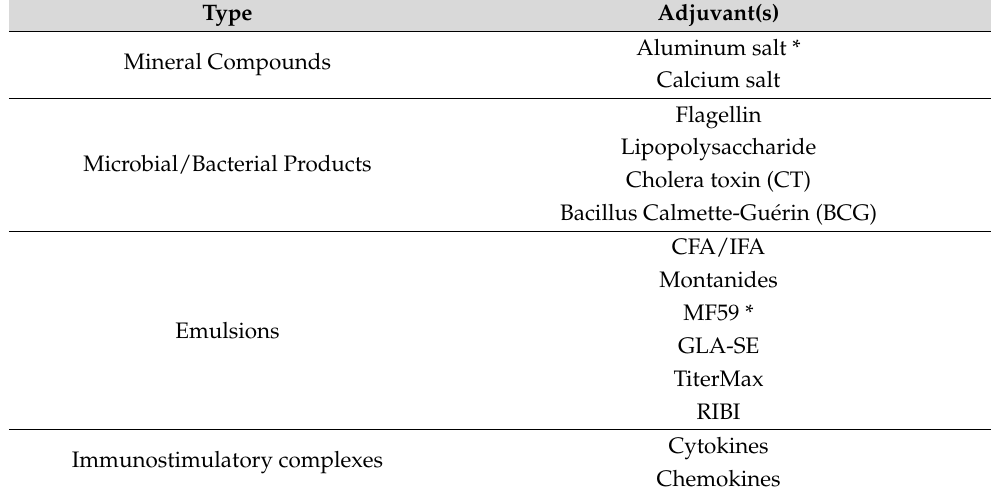
Table 1. Immunological adjuvants assessed as part of infectious disease